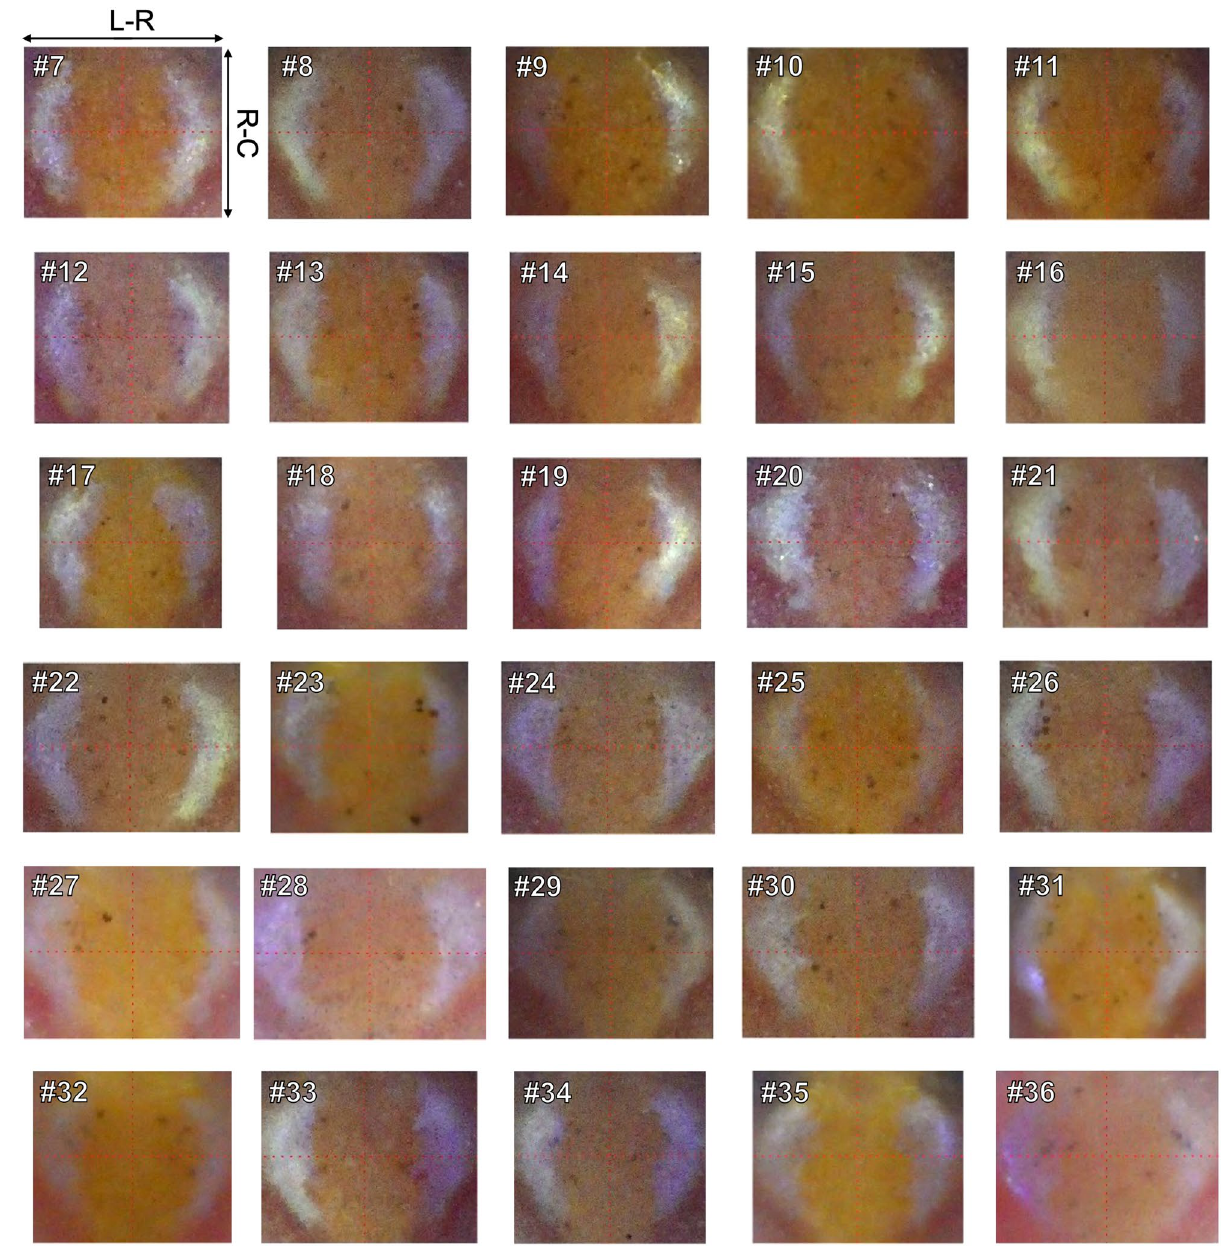
Figure 2. Individual distribution patterns of melanophore spots of 30 adult inbred medaka at the first time point. A number in each image corresponds to an individual identifier. The red dotted lines serve a guide. The Hd-rR strain (F97) was used as inbred medaka. Individuals #7, #9, #10–#13, #16, #17, #23, #25, #27, #29, #31, #32, and #35 were male, and Individuals #8, #14, #15, #18–#22, #24, #26, #28, #30, #33, #34, and #36 were female. R-C: rostral-caudal axis, L-R: left-right